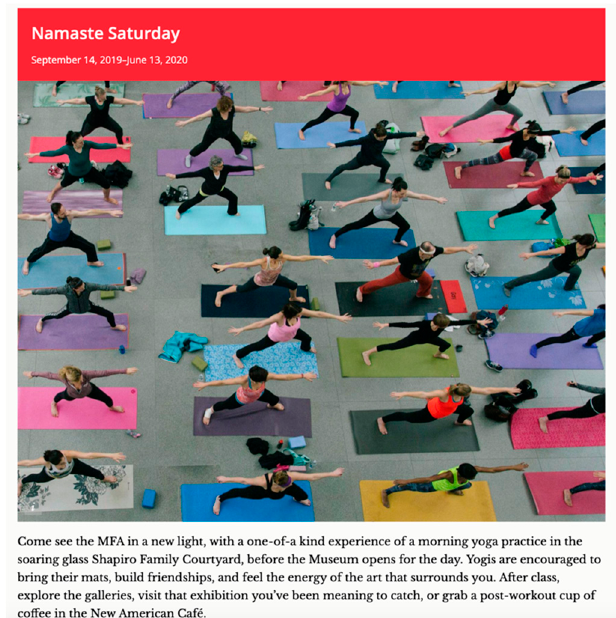
Figure 4. Advertisement for “Namaste Saturday” at the MFA. Source: mfa.org.